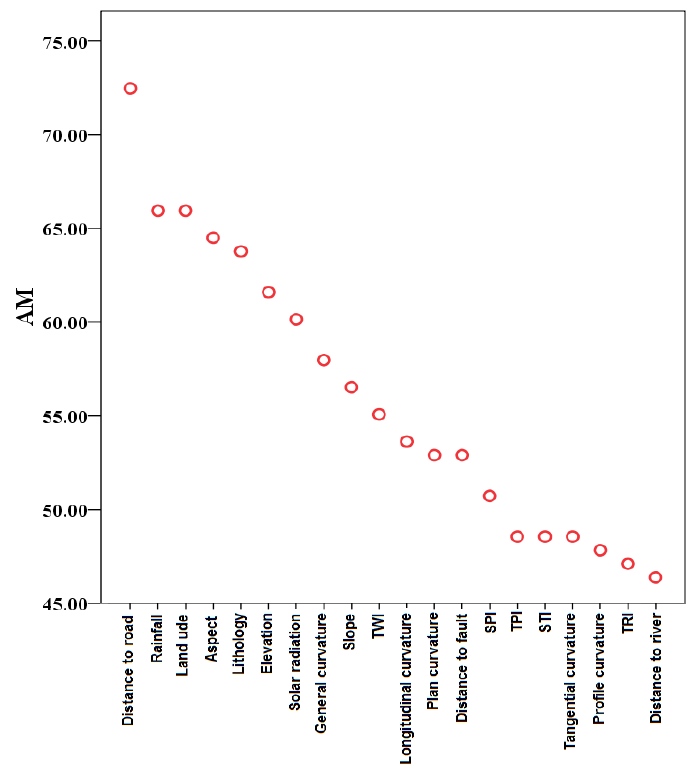
Figure 6. Factor scores determined using the ORAE technique.